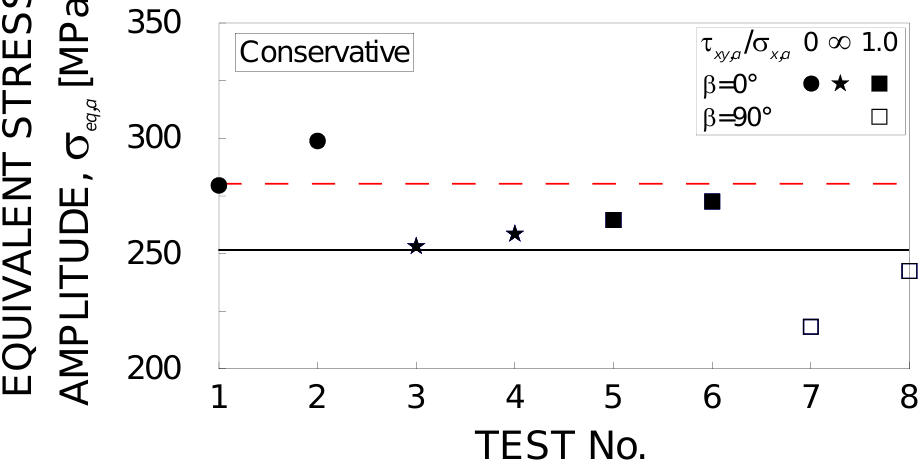
Figure 8. Equivalent stress amplitude vs. test No. computed according to the present procedure for EN-GJS-700-2 DCI.